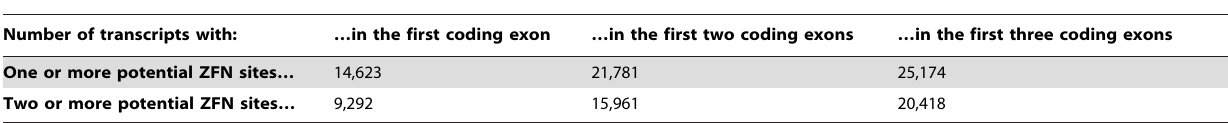
Table 3. Summary of potential OPEN ZFN target sites identified in zebrafish transcripts